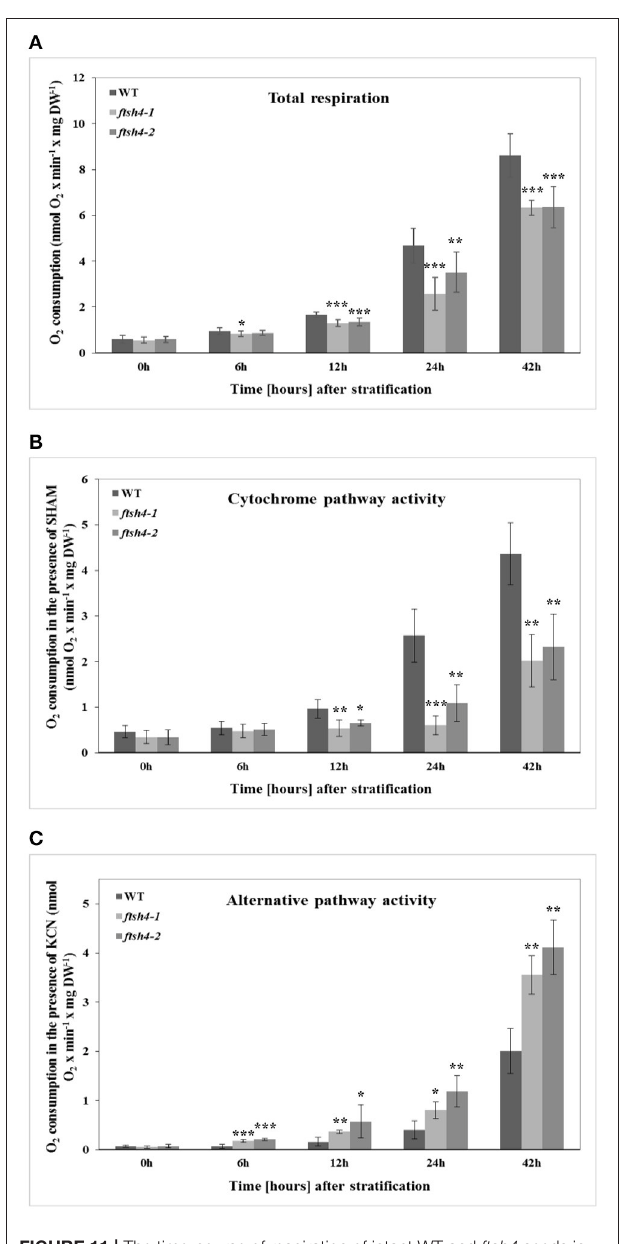
FIGURE 11 | The time-course of respiration of intact WT and ftsh4 seeds in the absence (A) or presence of either SHAM (B) or KCN (C) . Oxygen consumption rates (nmol O 2 x min − 1 x mg dry weight − 1 ) by WT and ftsh4 seeds were measured at 30 ◦ C using a Clark-type O 2 electrode. (A) Total respiration of intact germinating WT, ftsh4-1 and ftsh4-2 seeds. (B) SHAM-insensitive respiration reflecting the COX-mediated O 2 consumption by germinating WT and ftsh4 seeds in the presence of 3mM SHAM. (C) KCN-insensitive respiration reflecting the AOX-mediated O 2 consumption by germinating WT and ftsh4 seeds in the presence of 2mM KCN. In all experiments, seeds were stratified and either directly transferred to the chamber for O 2 consumption measurements (0h) or germinated for a given time (6, 12, 24, 42h) at 30 ◦ C followed by measurements of oxygen uptake. Stratification consisted of pre-treatment of seeds for 48h at 4 ◦ C in the dark. Data are mean ± SD of at least four independent experiments. * p ≤ 0.05, ** p ≤ 0.01, *** p ≤